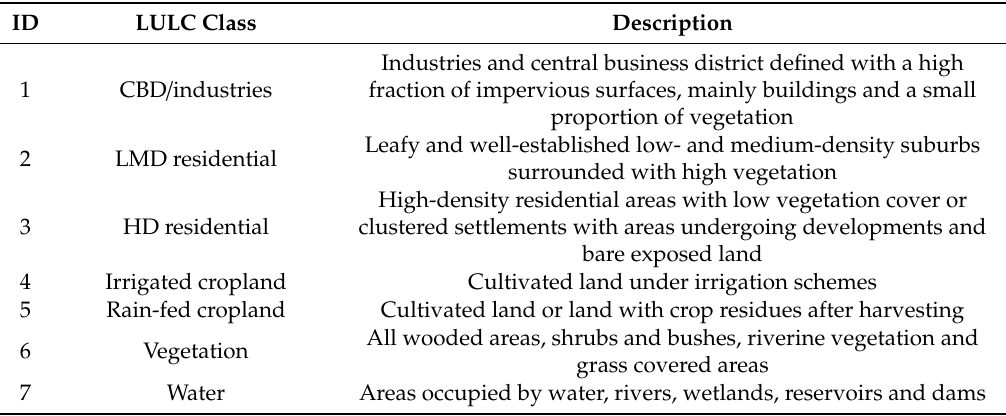
Table 2. Description of the study LULC